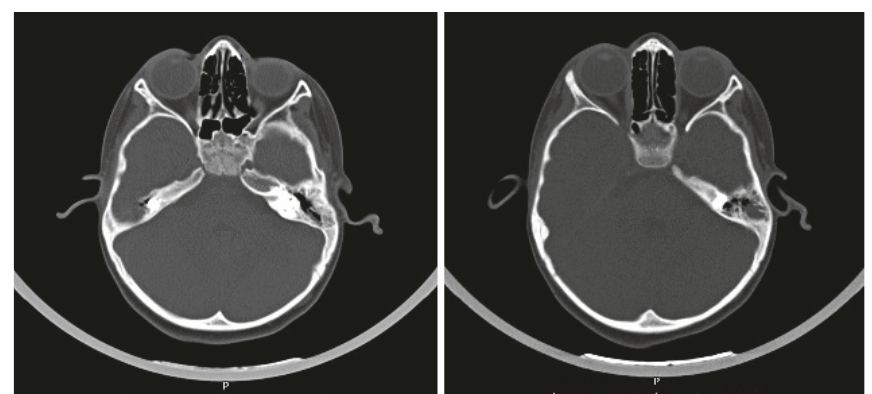
Figure 5: Postchemotherapy CT scans of the